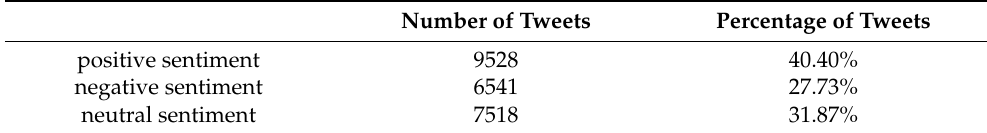
Table 4. Overall sentiment values for the collected data.